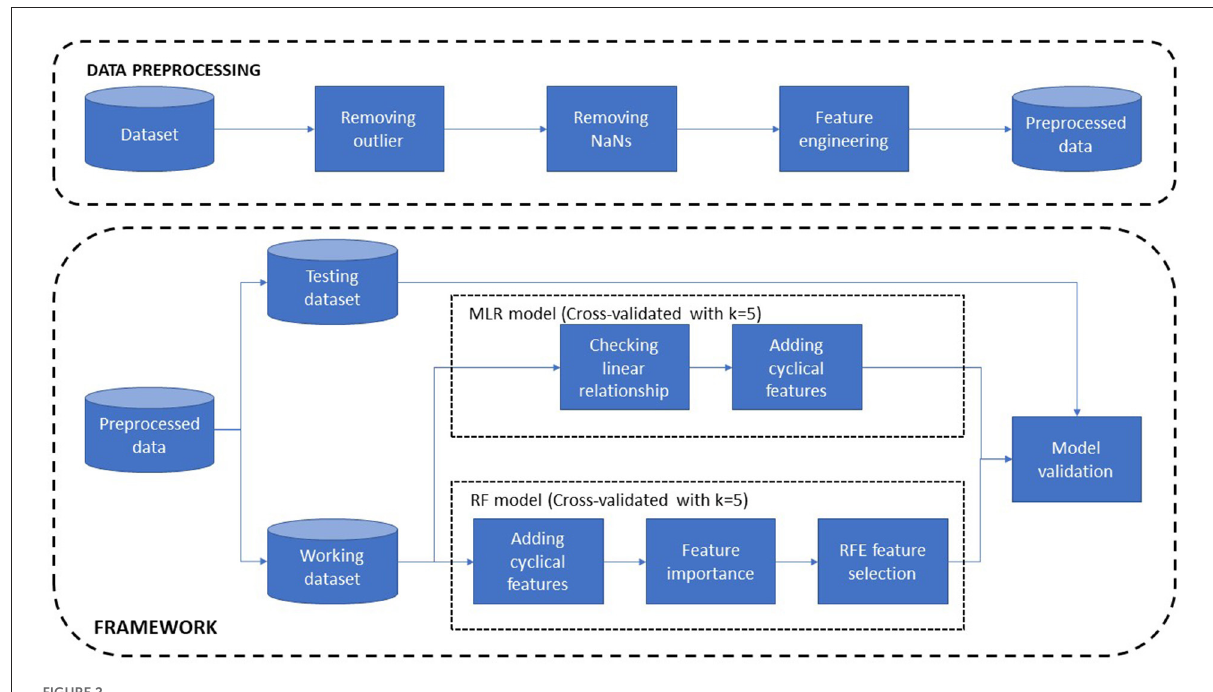
FIGURE2 The overview of data preprocessing and